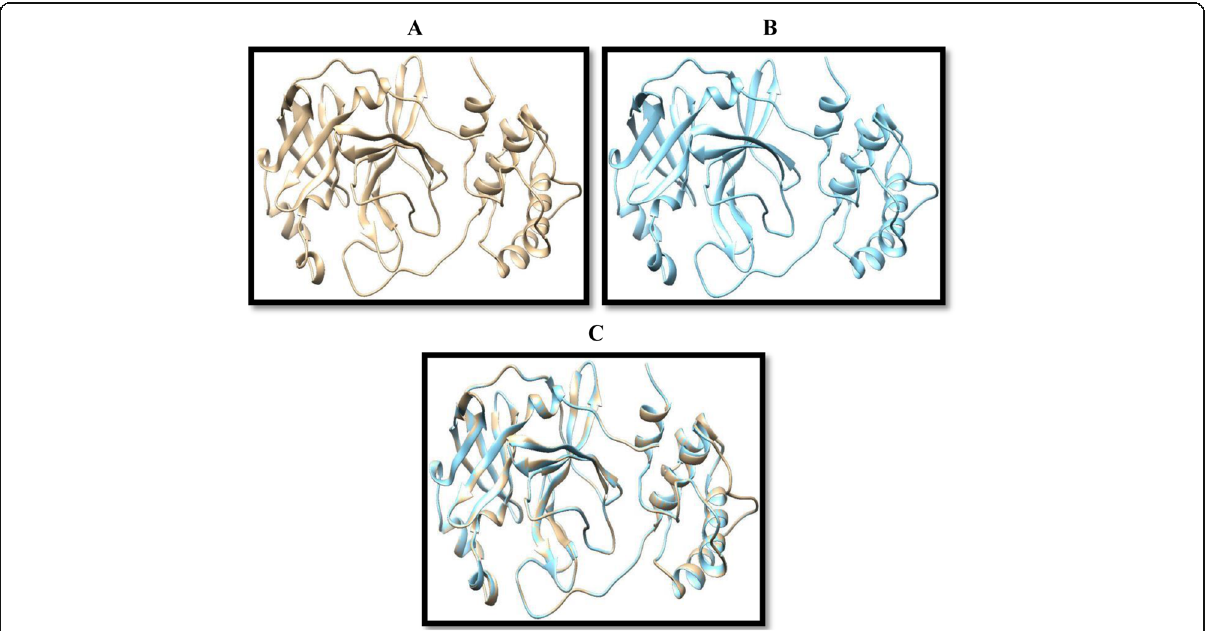
Fig. 3 3D structures of the target and template protein, with the structural comparison. The target protein is represented at the top left region in grey color ( a ), while the template is on the top right in light blue color ( b ). The matching together of the two was depicted in the mixed color picture beneath ( c )